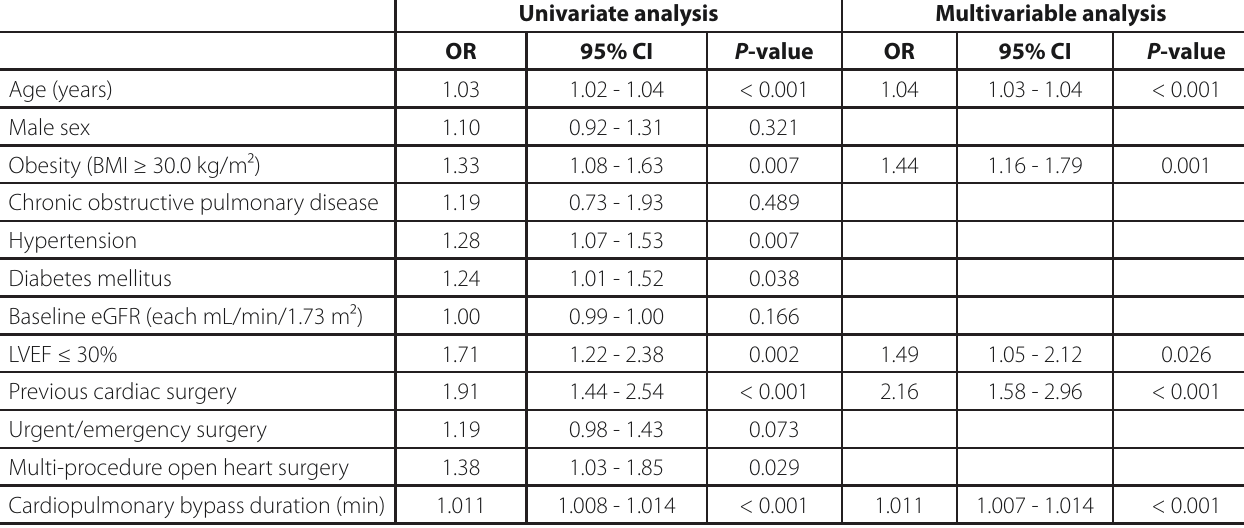
Table 3. Multivariable analysis using logistic regression models — odds ratio (OR) and 95% confidence intervals (CI) for predictors of CSA-AKI based on KDIGO